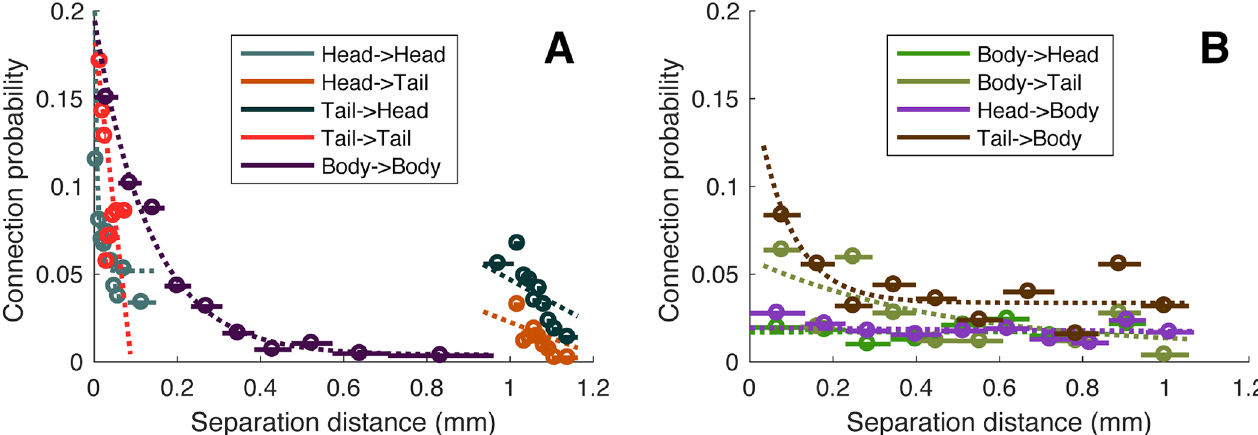
Fig 3. Connection probability decreases with separation distance within and between the head and tail, and within the body. The connection probability for a pair of neurons as a function of their Euclidean distance is estimated in 10 equiprobable distance bins, shown as a circle (bin centers) and a horizontal line (bin extent). There is a decreasing relationship for connections: within the head (aqua), from head ! tail (brown) and from tail ! head (stone blue), within the tail (red), and within the body (dark purple). Exponential fits of the form f ( x ) = A exp( − λ x ) + B , some of which appear approximately linear across the range of the data, are shown as dotted lines. (B) Plots as in (A), but for connection classes between the body and head/tail: from body ! head (forest green), from body ! tail (dirt green), connections from head ! body (purple), and from tail ! body (dark brown). Apart from a small effect at short range for tail ! body connections, these connection classes show minimal distance dependence.